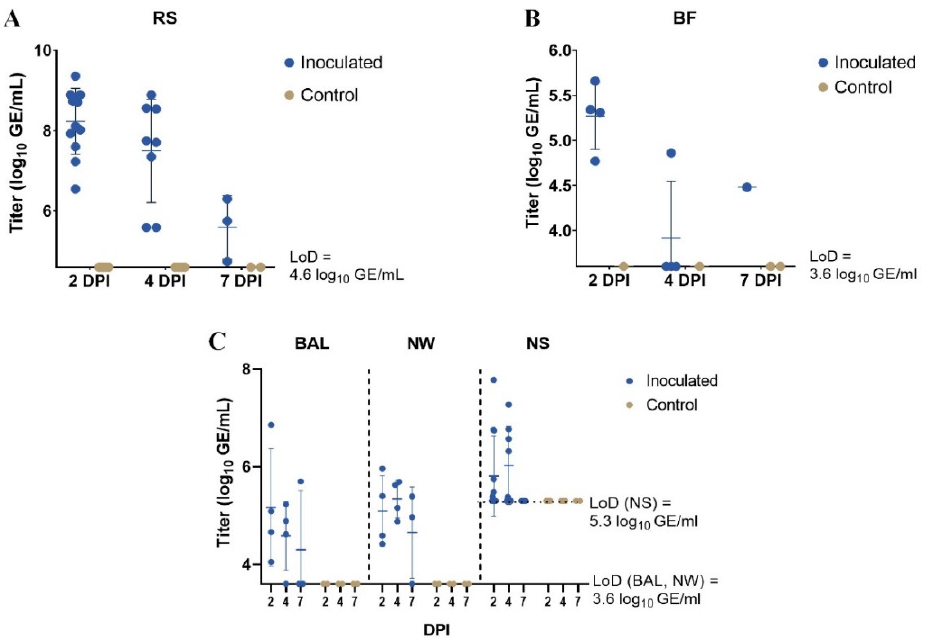
Figure 1. Detection of viral RNA in ( A ) rectal swab (RS), ( B ) biliary fluid (BF), ( C ) bronchoalveolar lavage (BAL), nasal wash (NW), and nasal swab (NS) samples with viral titers (log 10 GE/mL) based on RT-qPCR results. Limit of detection (LoD) was 4.6 log 10 genome equivalents (GE)/mL for RS, 3.6 log 10 GE/mL for BF, BAL, and NW, and 5.3 log 10 GE/mL for NS. The number of samples with titers above the LoD is summarized in Table 1. All negative control samples had RNA levels below the LoD. The middle line and the bars indicate the mean ± SD. The figure was created with GraphPad Prism. Table 1. Viral RNA detection in rectal swab (RS), biliary fluid (BF), bronchoalveolar lavage (BAL), nasal wash (NW), and nasal swab (NS) samples from inoculated and control piglets at 2, 4, and 7 days post-inoculation (DPI). Number of positive samples by RT-qPCR (i.e., with titers above the limit total, 13 BF samples were tested; the remaining piglets were not tested due to either early of detection (LoD)) of all tested within a sample type. DPI BF Inoculated piglets